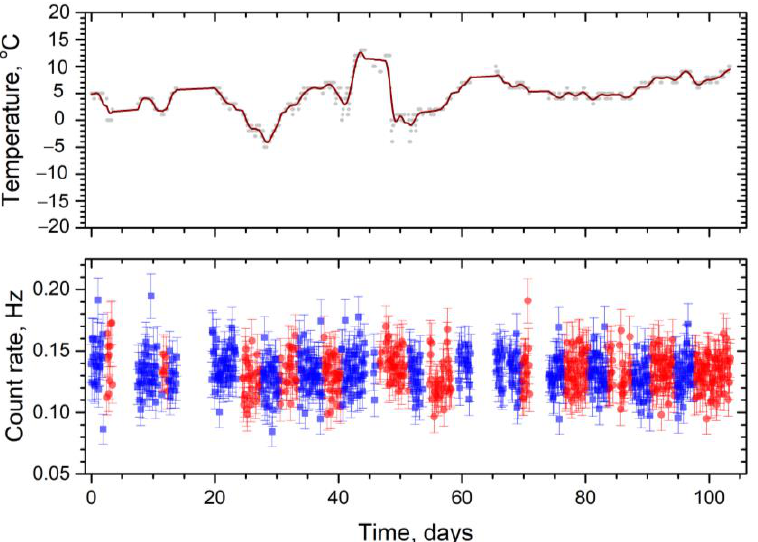
Figure 3. The count rates measured in configuration 1 (red) and configuration 2 (blue). Upper diagram shows the temperature of the counter during measurements.